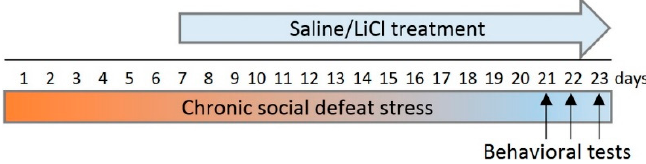
Figure 1. An outline of the experiment: chronic LiCl and/or saline treatment of defeated mice in preventive mode starting from the 7th day of the agonistic interactions in order to study the possible protective effect of LiCl on the development of behavioral pathology. Behavioral tests: day 21, the partition test; day 22, the elevated plus-maze test; and day 23, the social interaction test.